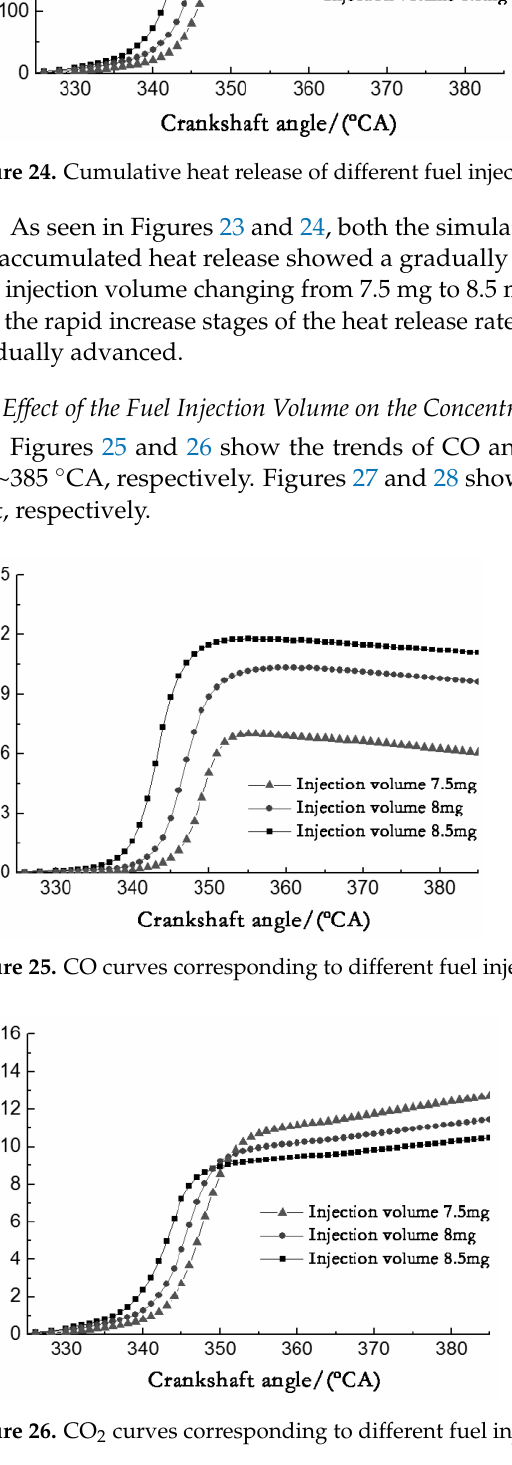
Figure 24. Cumulative heat release of different fuel injection volumes.